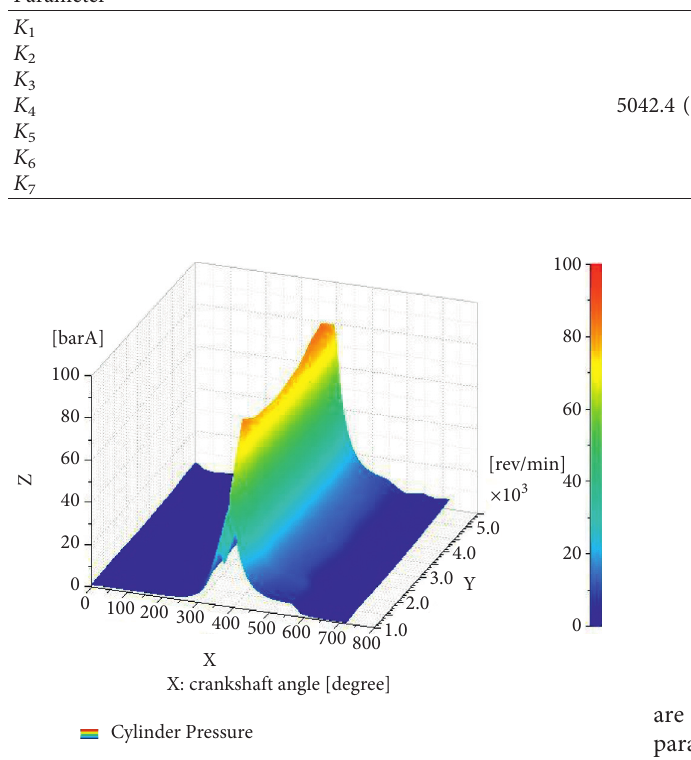
Figure 5: Engine cylinder pressure data.